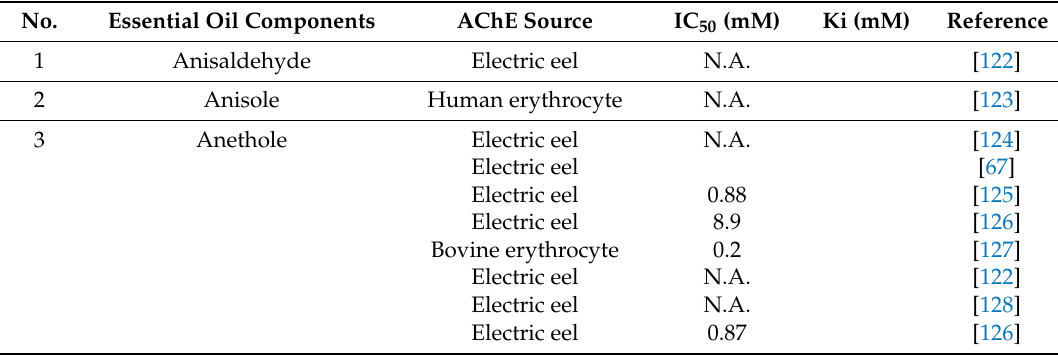
Table A1. The effects of the essential oil components on the acetylcholinesterase activity in organisms other than